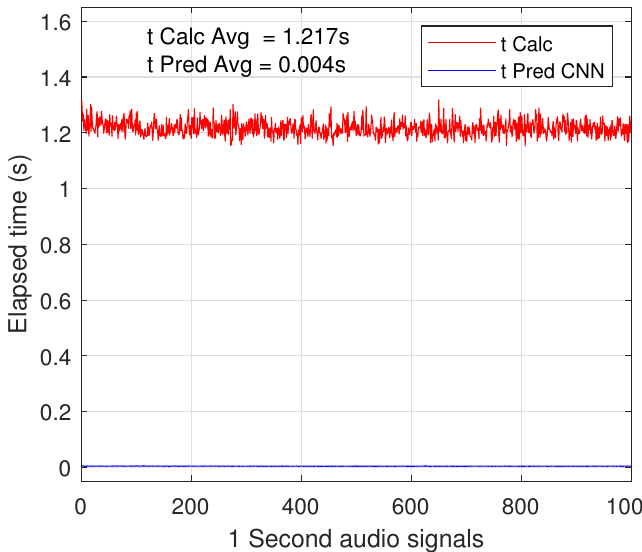
Figure 5. Elapsed time in direct calculation and elapsed time in